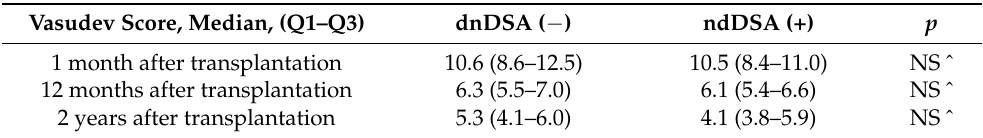
Table 5. Median values of cumulative Vasudev score between 1st and 24th month after transplanta- tion in the prospective